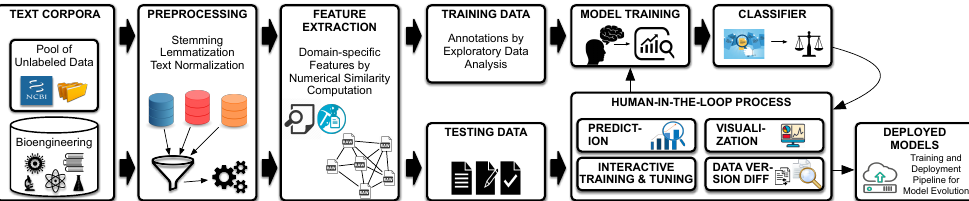
Figure 10. The overview of our human-in-the-loop workflow for reaching target accuracy for a learning model faster, for maximizing accuracy by combining human and machine intelligence, and for increasing efficiency in assisting end user tasks with machine